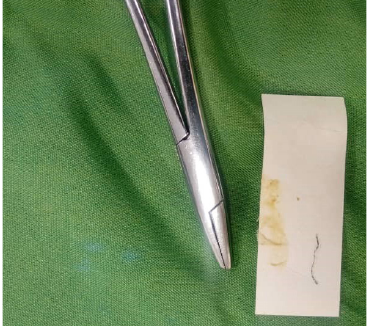
Figure 2. The removed steel wool